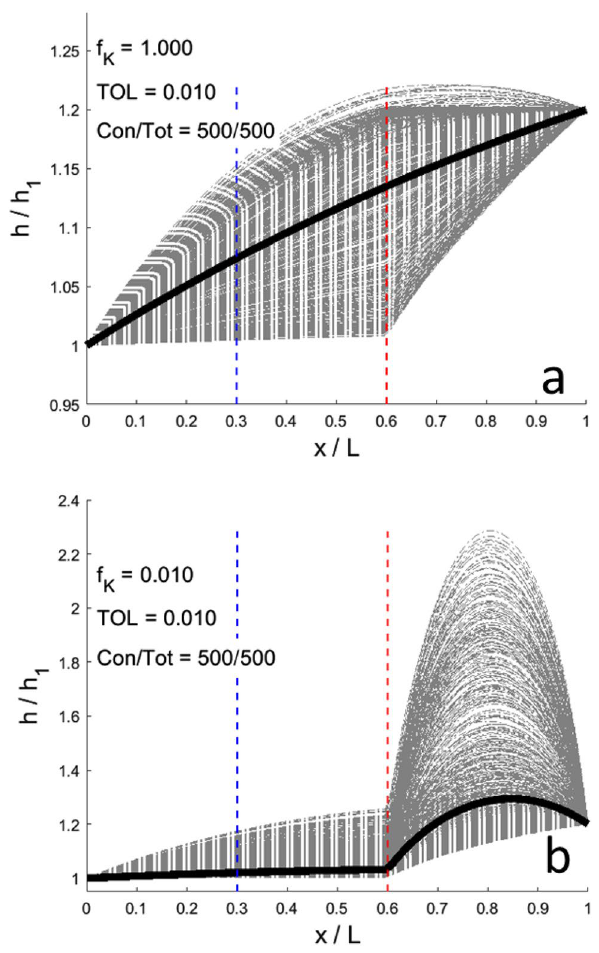
Fig. 7 Water table for different combinations of randomly gener- ated values of K 1 and K 2 . Thick black line shows the water table for the combination of parameters that represents the virtual reality site. Dashed red line shows position of interface between materials x K and blue line shows position of well with measured head Homogeneous and b heterogeneous aquifer. Note: f K corresponds to ratio between both scales k 1 and k 2 , thus for f K = 1.0 , K 1 ∕ K 2 ranges between [ 0.01,100.0